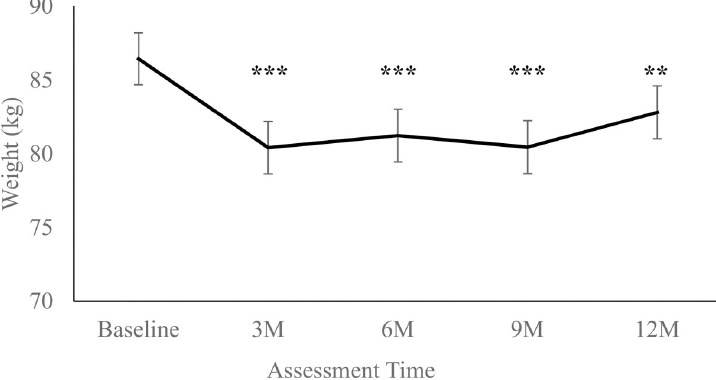
Fig 1. Model-estimated averages (mean ± SE) of participant weight (kg) at each assessment point. Legend: M = Month. ��� indicates p < .001, �� indicates p < .01, and � indicates p < .05, compared to baseline.